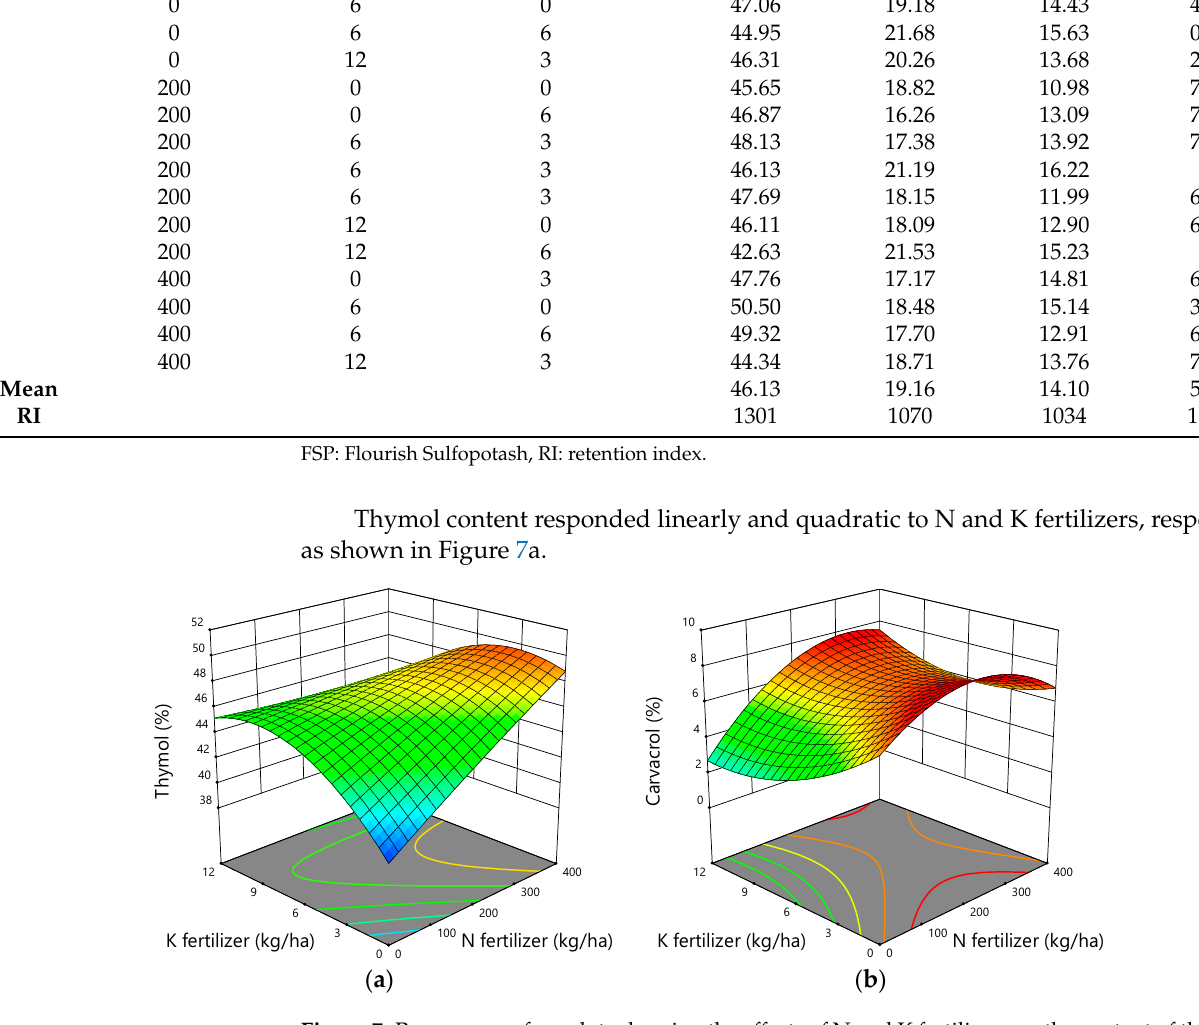
Figure 8. Response surface ( a ), and contour plot ( b ) showing the effect of N fertilizer and seaweed extract on the carvacrol content. The K fertilizer was kept constant at 6 kg ha − 1 .